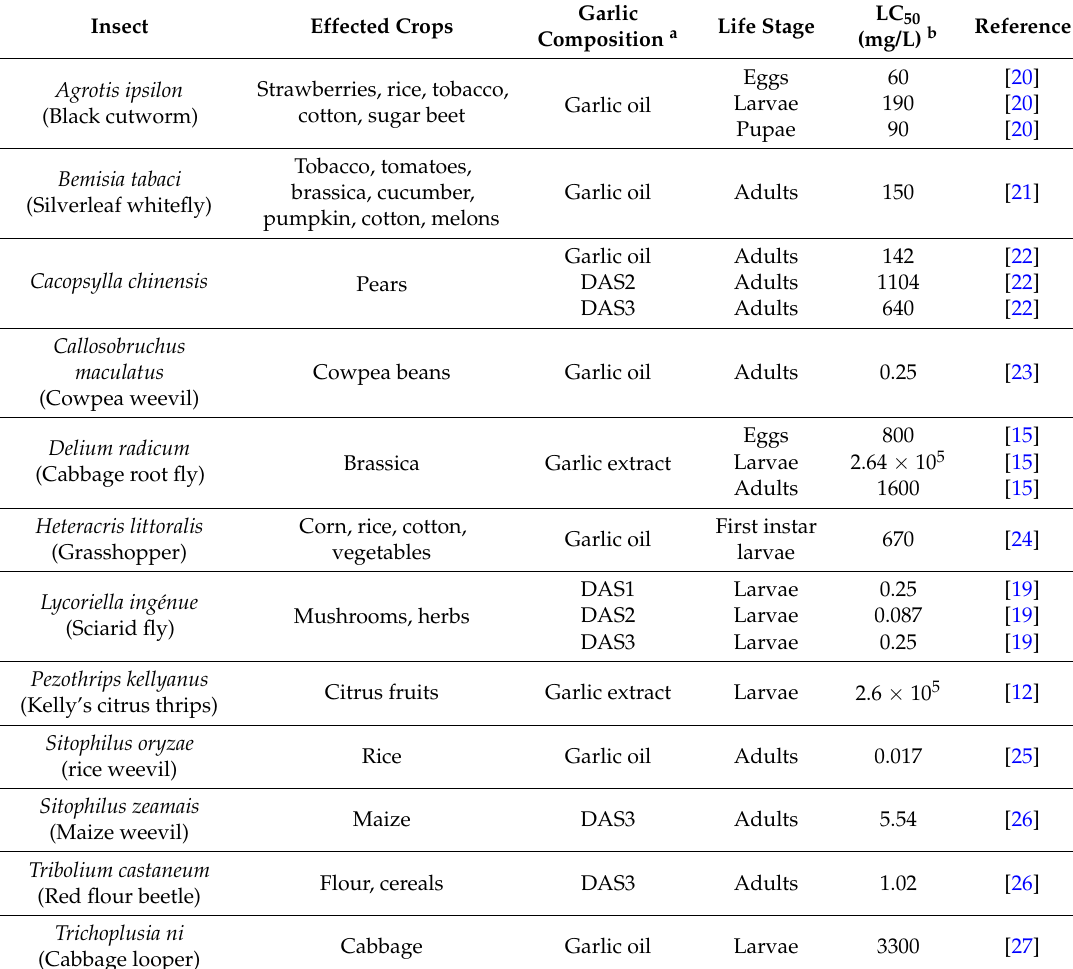
Table 1. Efficacy of different garlic compositions on a range of plant pathogenic